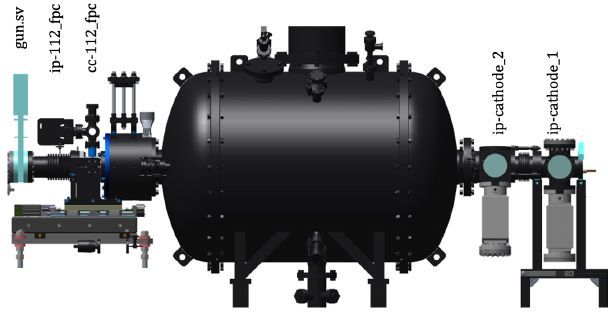
FIG. 3. Detailed view of the SRF gun cryostat with the critical vacuum components. The cathode insertion is on the right side of the schematic and the FPC is on the left side. Here ip ¼ ion pump; tc ¼ thermal conductivity gauge, reads pressure from atmosphere to 1 × 10 − 3 Torr; cc ¼ cold cathode gauge, reads 1 × 10 − 3 to 1 × 10 − 11 Torr; sv ¼ vacuum